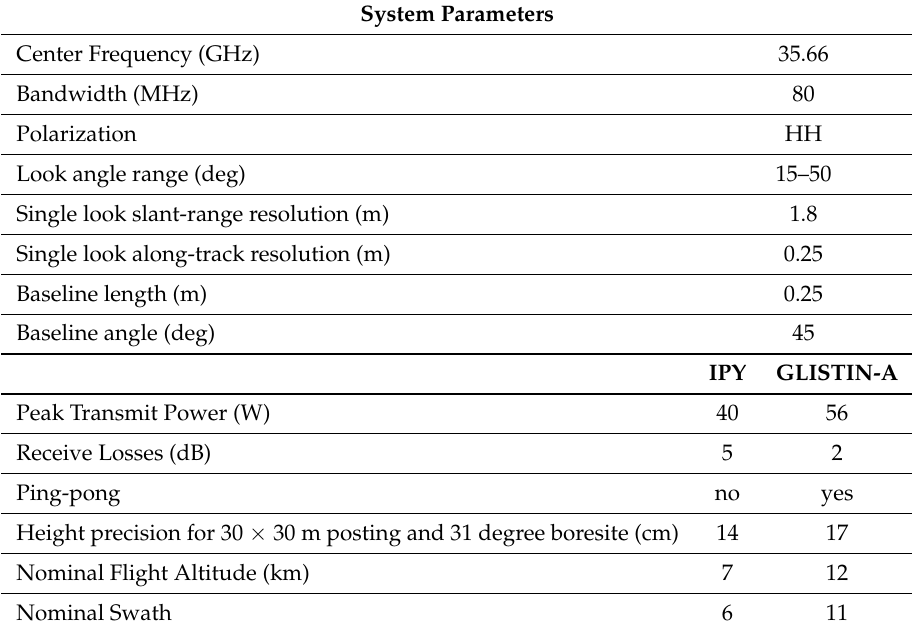
Table 1. Summary of Upgrades and Mapping